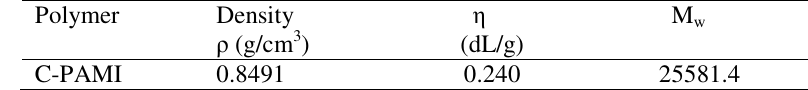
Table 5 . The Intrinsic viscosity, density and molecular weight of C-PAMI. Polymer Density (cid:3) (g/cm 3